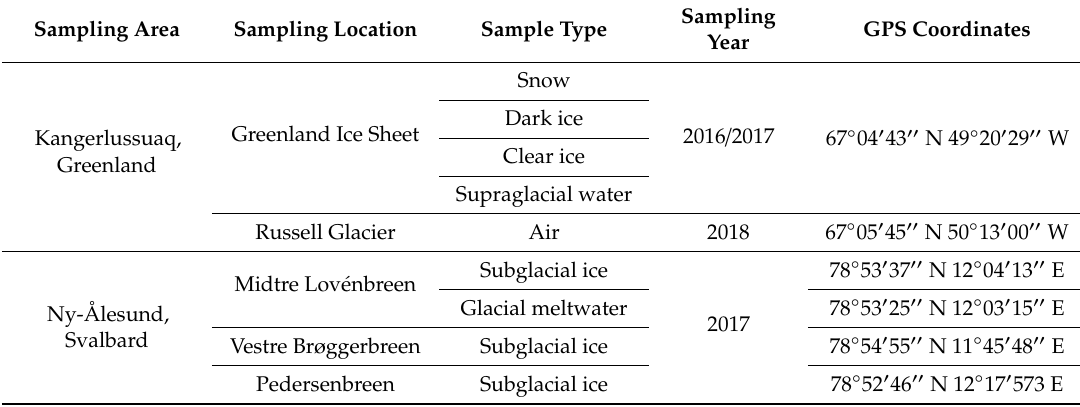
Table 1. Sampling area and year, sample types, and GPS coordinates of the sampling